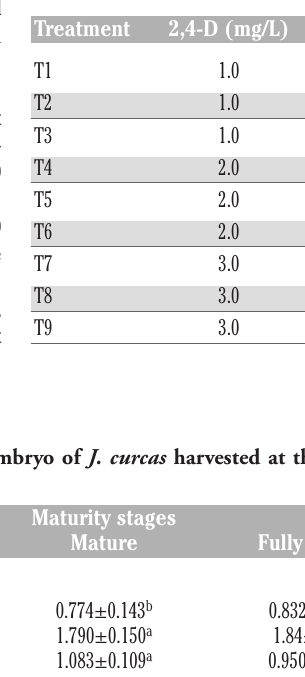
Table 1. Concentrations and combinations of plant growth regulators used for callus induction.